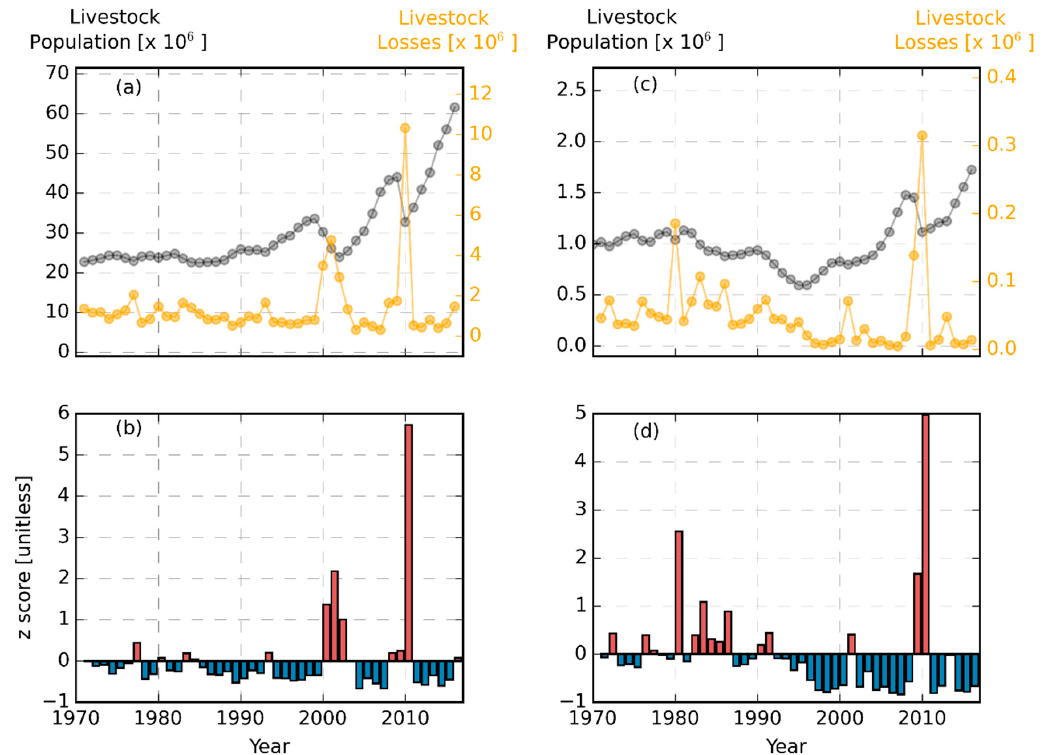
Figure 2. ( a ) Livestock population and losses for Mongolia from 1971–2016. ( b ) Standardized z-scores for annual livestock losses. ( c ) Livestock population and losses for Dornod aimag from 1971–2016. ( d ) Standardized z-scores for annual livestock losses in Dornod aimag. *Note the independent y-axis scales for each